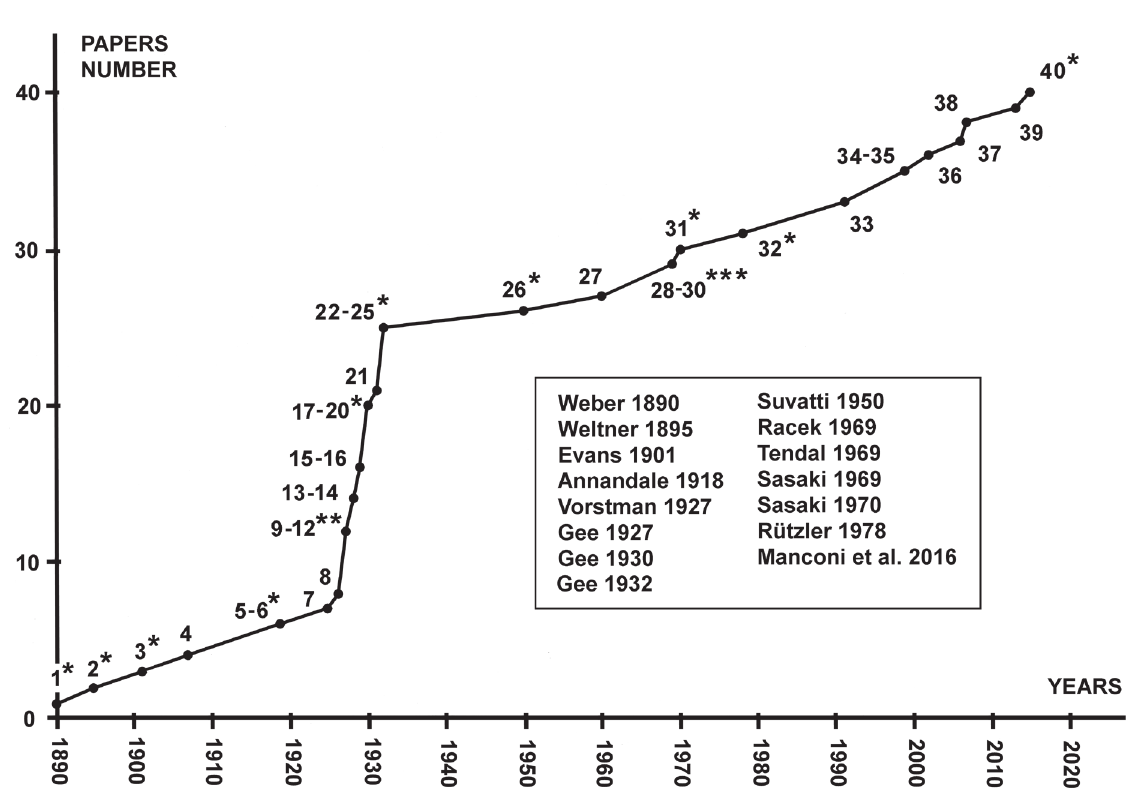
Fig. 7. Historical trend of faunistic and taxonomic investigations focusing on Umborotula bogorensis (Weber, 1890). The papers mentioning this species are 40. The 15 papers (box) reporting new records are indicated by asterisks. See also Fig. 1 (map) and